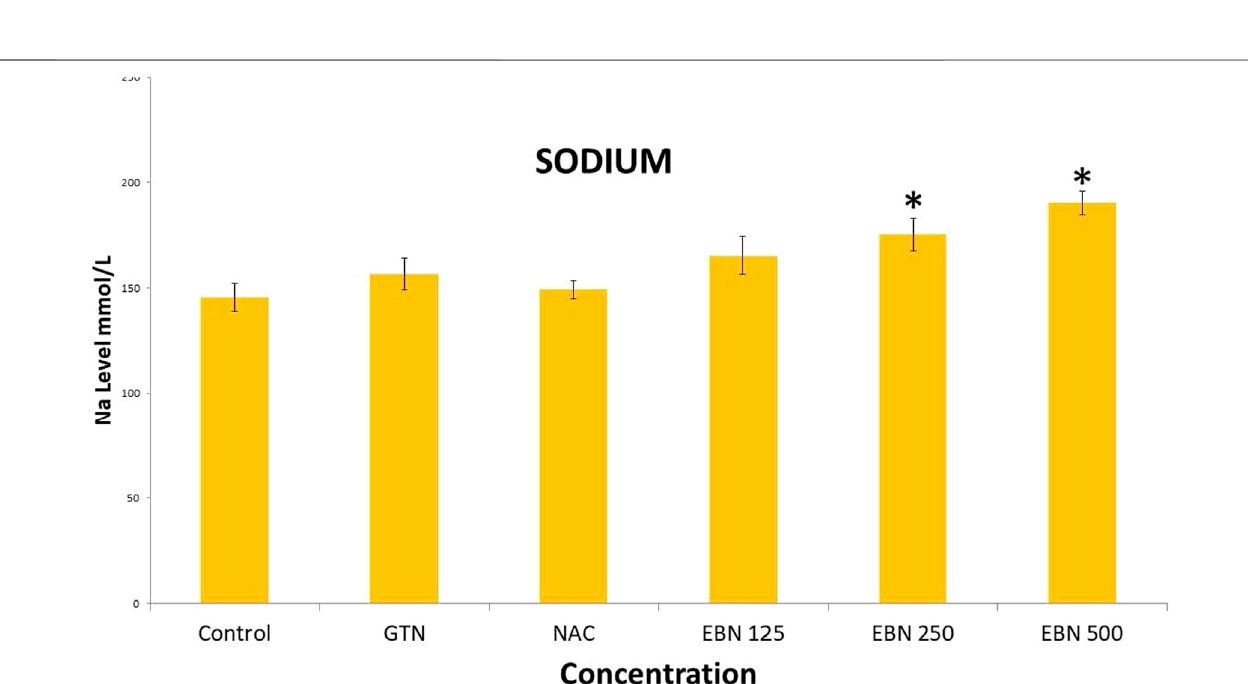
FIGURE 13 | Changes of serum sodium vs different post-treatment group (* p < 0.05 compare to gentamicin group).